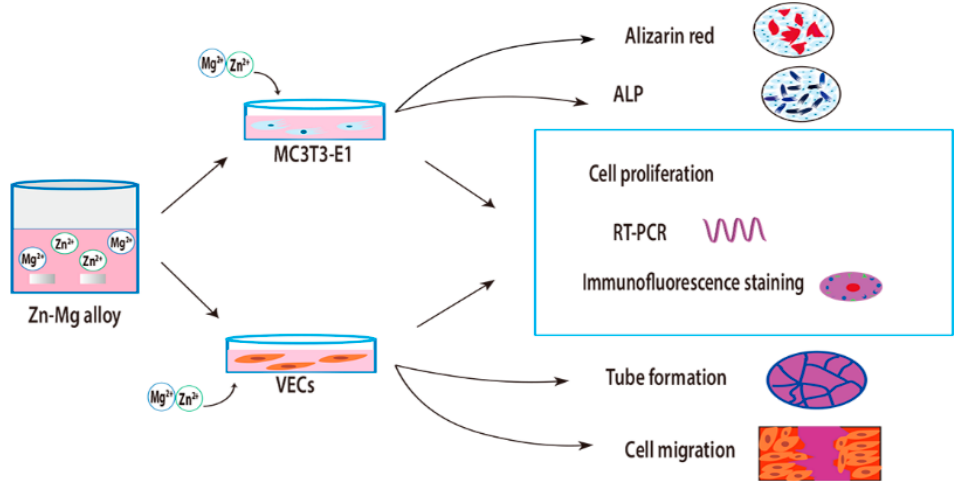
Figure 1. Schematic diagrams of the experimental design and protocol.